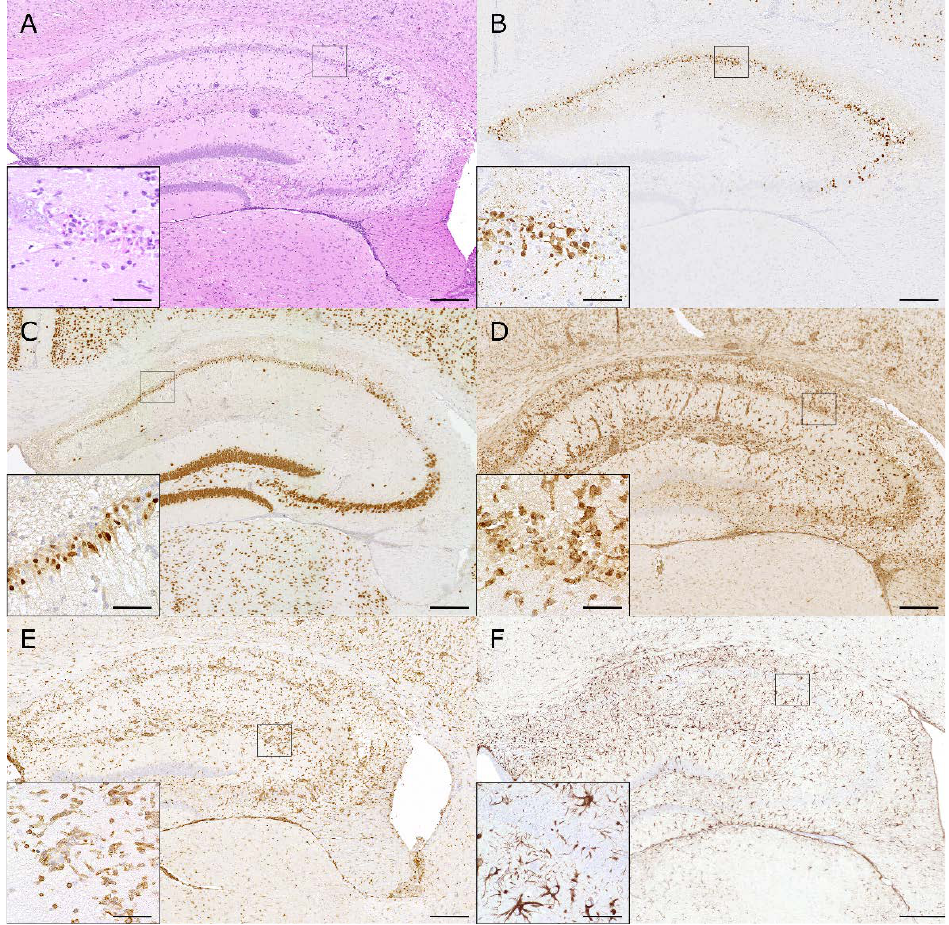
Figure 4. Hippocampal lesions induced by Theiler’s murine encephalomyelitis virus in C57BL/6 mice: ( A ) Intracerebral infection of C57BL/6 mice with the DA strain of TMEV causes hippocampal inflammation (HE) and neuronal pyknosis. ( B ) The TMEV antigen is mainly localized in pyramidal neurons of the CA1 and CA2 region at 7 days post infection (dpi). ( C ) Marked pyknosis and loss of NeuN-positive neurons are seen in the hippocampus at 7 dpi. ( D ) Prominent infiltration of macrophages and activation of microglia (MAC3/CD107b) are seen in the hippocampus at 7 dpi. ( E ) Numerous T cells (CD3) are seen in the hippocampal lesions at 7 dpi. ( F ) Neuronal degeneration and inflammatory changes are associated with strong astrogliosis (GFAP) at 14 dpi. ( A – F ) The inserts show higher magnifications of the areas delineated by the black squares. The bars represent 200 µm and 20 µm for overviews and inserts, respectively.